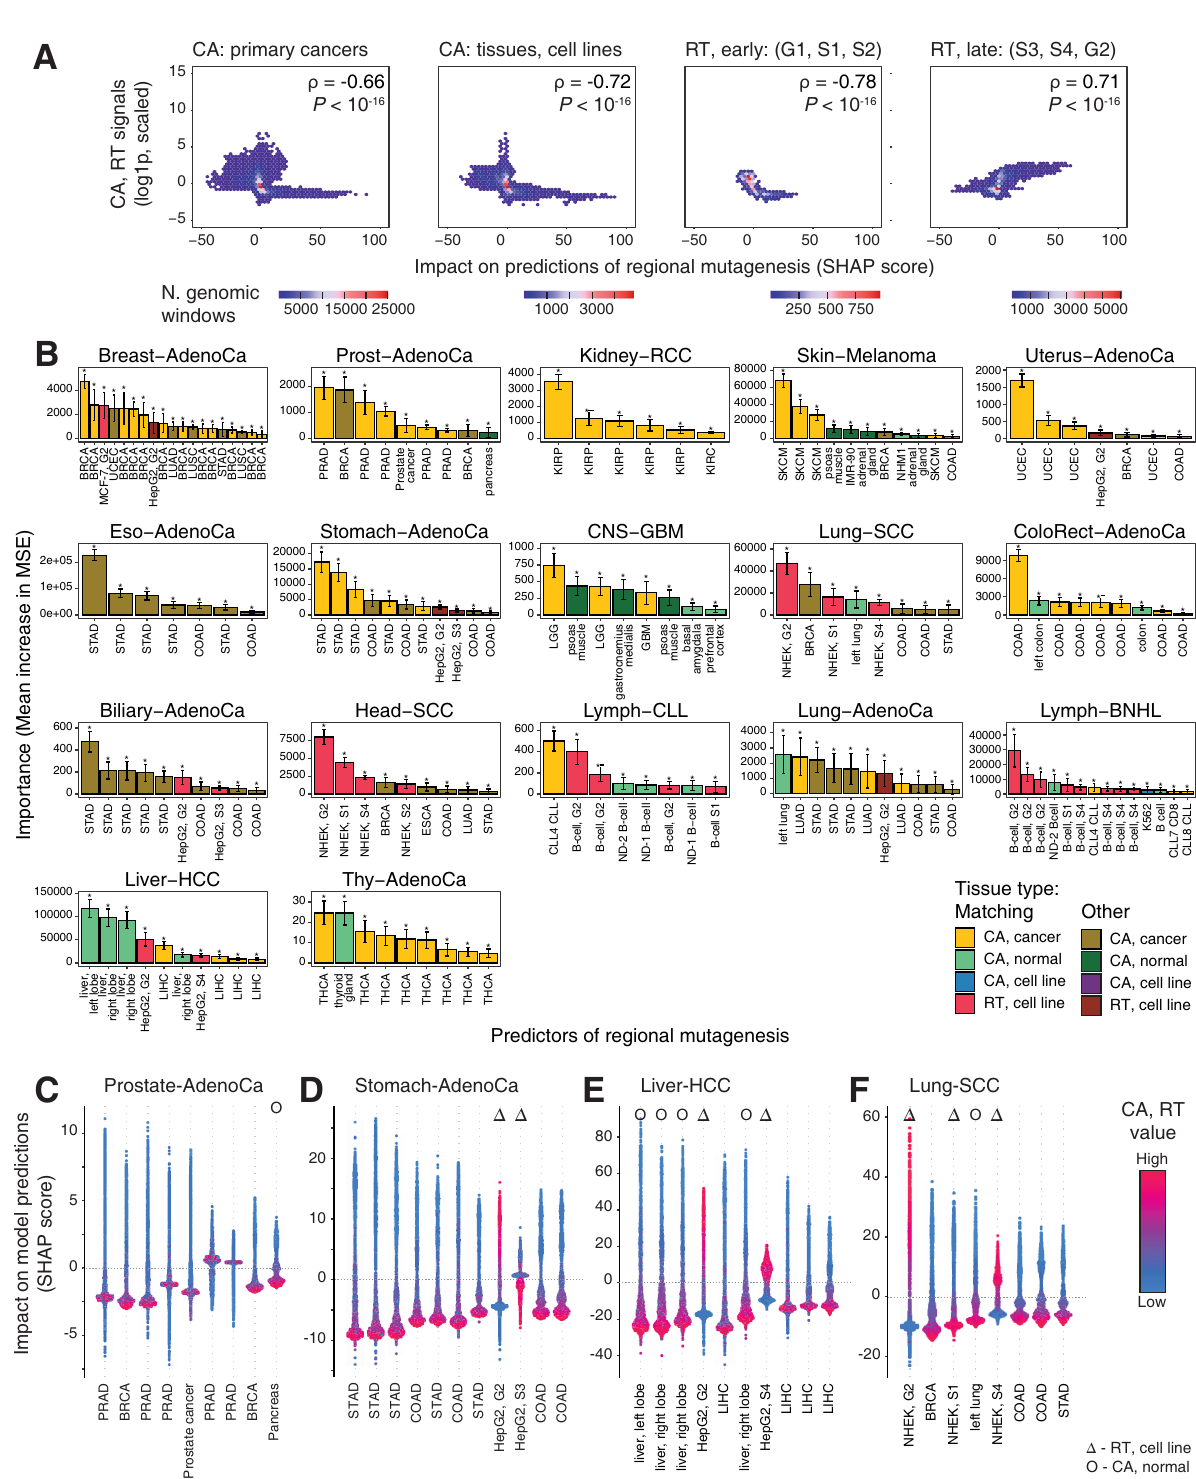
Fig 3. Top predictors of regional mutagenesis tie cancer types and sites of origin. A. 2D-density plots show the association CA and RT scores (Y- axis) and Shapley feature importance (SHAP) scores in each genomic window (X-axis) across all cancer types for significant predictors (permutation P < 0.001). CA profiles for cancer and normal samples, early RT profiles, and late RT profiles are plotted separately. CA and early RT profiles negatively correlate with regional mutation burden while late RT profiles correlate positively. Spearman correlation values are shown (top right). B. CA profiles of primary cancers are the top predictors of regional mutagenesis in most cancer types. Bar plot shows the importance scores of